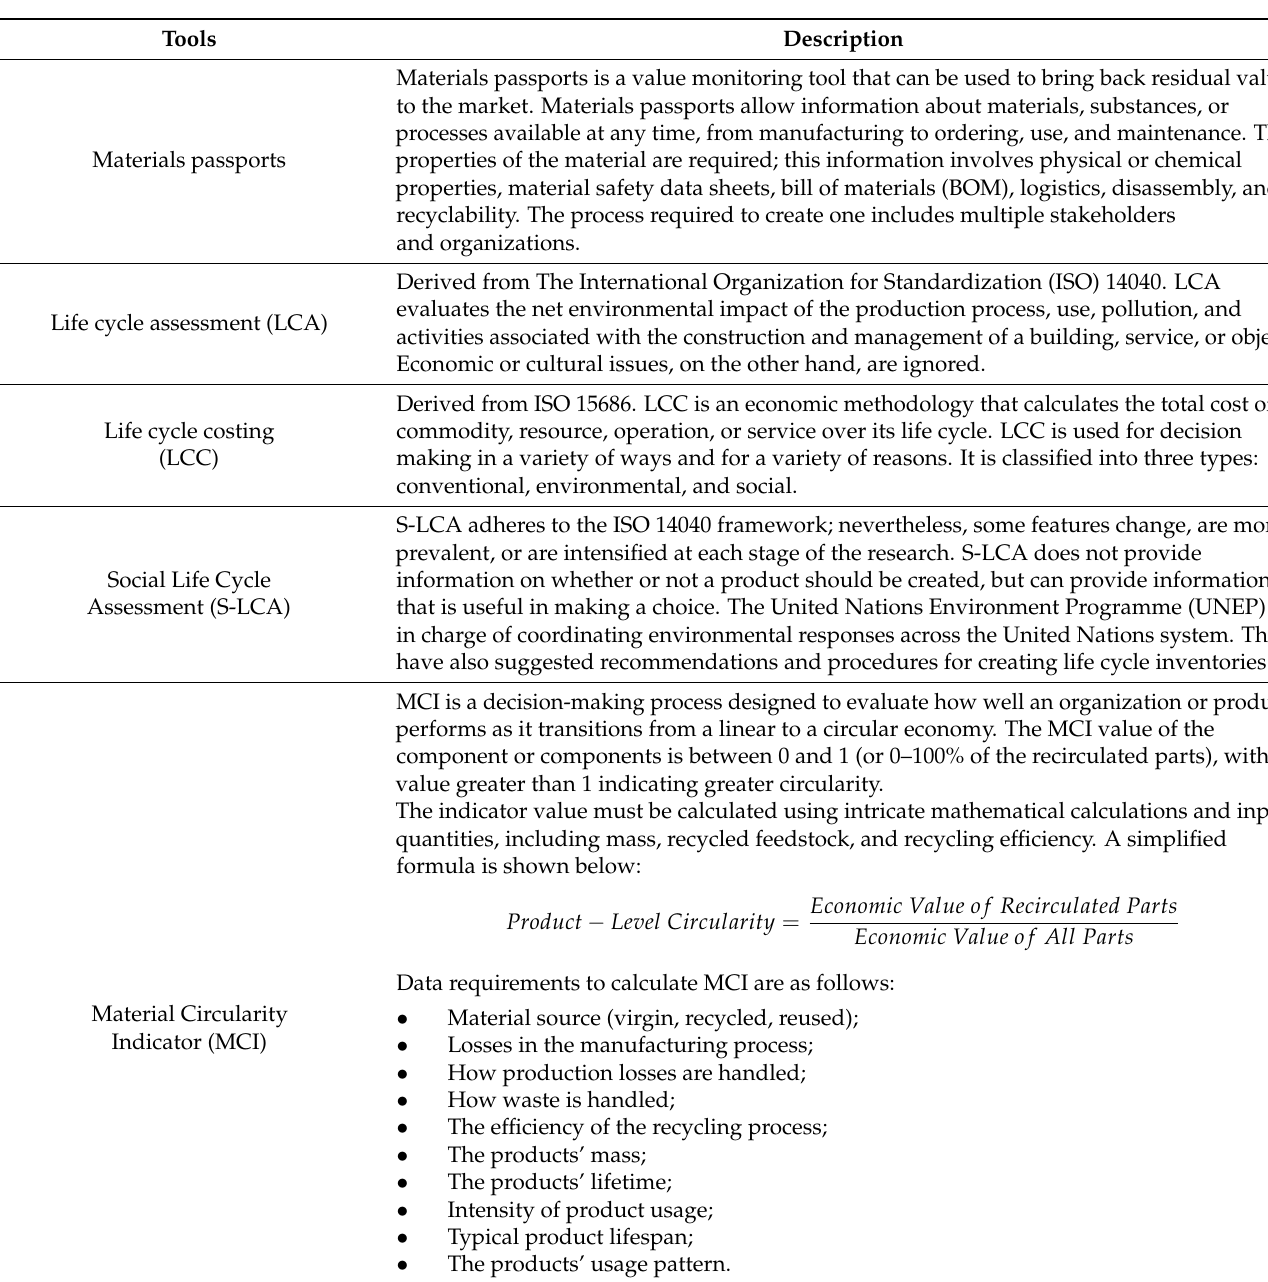
Table 1. Circular economy